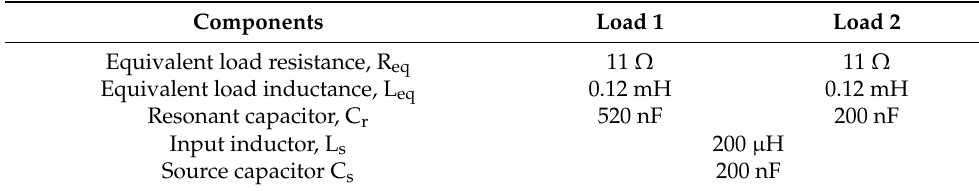
Table 1. Design specifications of AC-AC